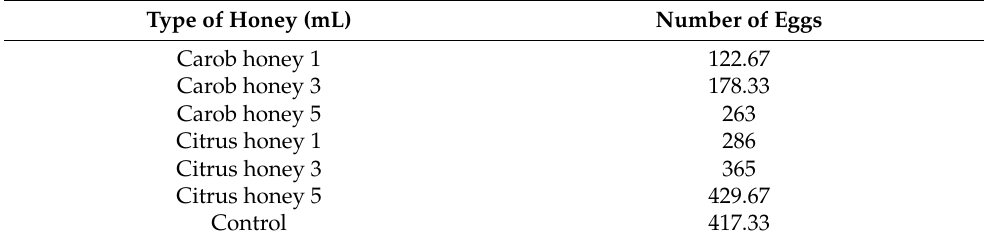
Table 4. The impact of different concentrations of carob honey and citrus honey on the number of eggs of Bombyx mori [38].